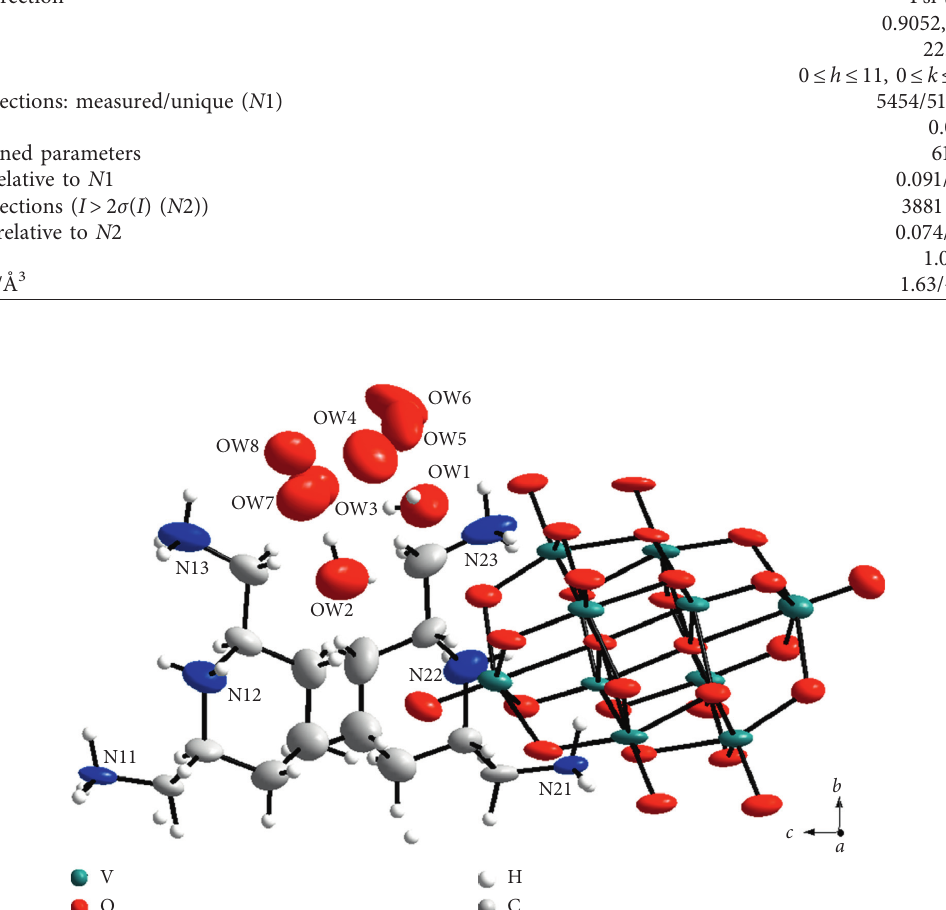
· 4.21H 7 N 3 H 20 ) 2 V 10 O 28 2 O. Displacement ellipsoids are drawn at the 50% probability